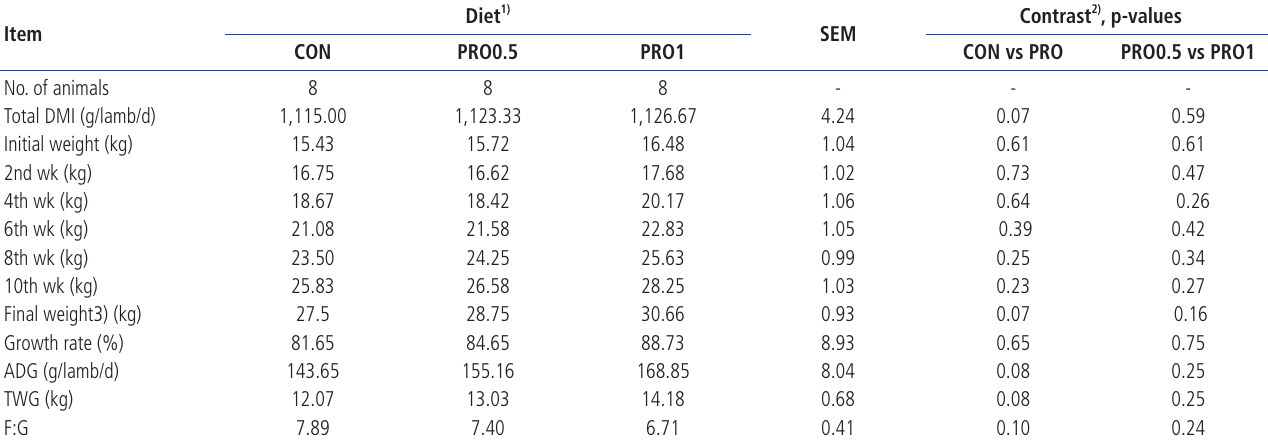
Table 4. Dry matter intake, growth performance, and feed conversion ratio of lambs fed control (CON), PRO0.5, and PRO1 diets during post-weaning period